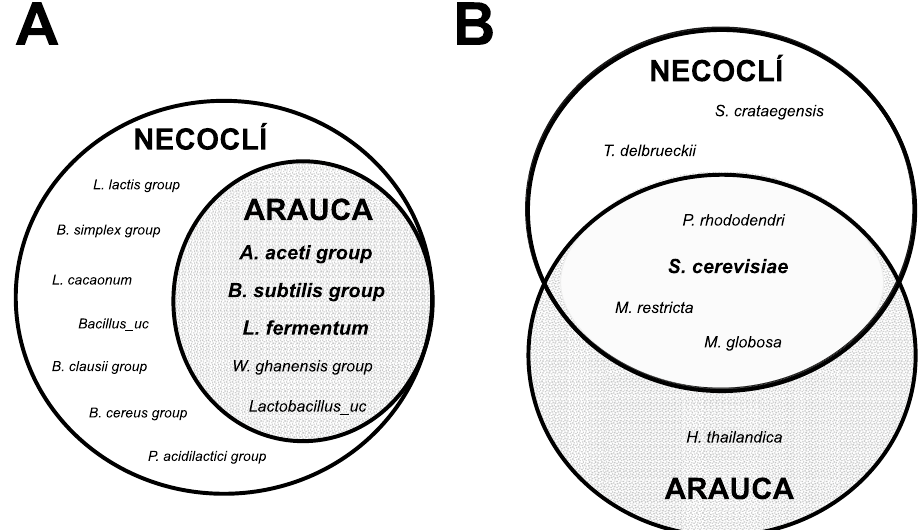
Figure 4. Schematic representation of dominant species observed during the fermentation of fine-flavour cocoa beans at Necoclí and Arauca farms. Dominant species were defined as species detected all over the replicates and showing a relative abundance higher than 1% from the total number of bacterial or fungal species. Data is shown for bacterial ( A ) and fungal species ( B ). Intersections on Venn Diagrams represent dominant species identified at both farms (here referred to as microorganism’s core). Bold highlighted names indicate the species selected for genome-scale metabolic model reconstruction that was later integrated to produce a community metabolic model for the fermentation of fine-flavour